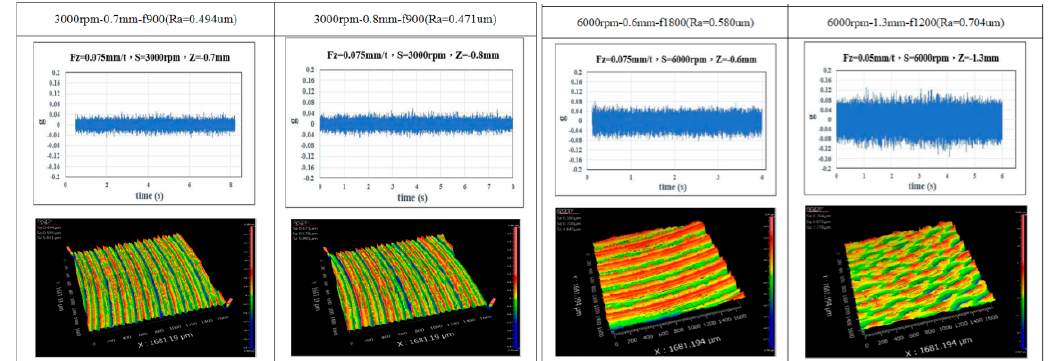
Figure 5. Morphologies of the machined surfaces under different cutting parameters.